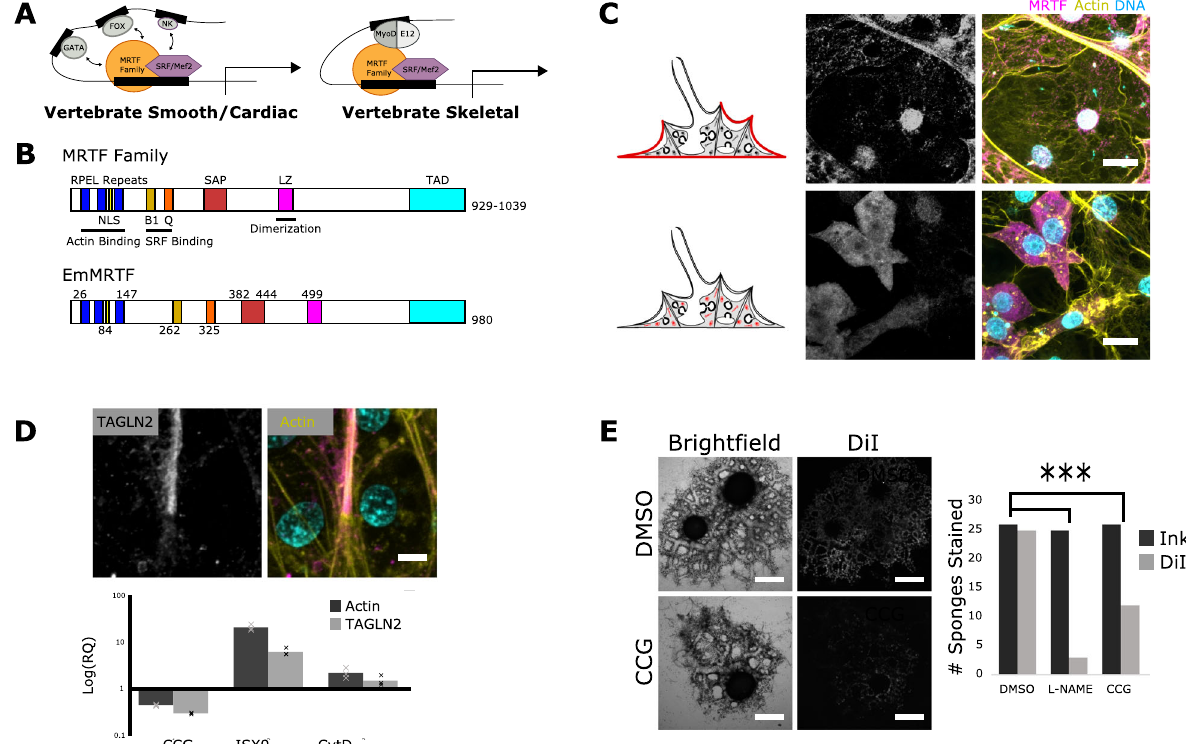
Fig. 5 Development of contractile structures depends on MRTF-activity. A Myocytes are developmentally speci fi ed by a transcriptional complex that includes MRTF interactions with SRF or Mef2. B Predicted domain organization of E. muelleri MRTF compared with vertebrate homologs (NLS; nuclear localization signal, B1, basic rich domain; SAP, SAP domain; LZ, leucine zipper; TAD, transcription activation domain). C Confocal images of pinacocytes (top) and archeocytes (bottom) immunostained for MRTF (grayscale and magenta), phalloidin (yellow), and Hoechst (cyan). Immunostainings for MRTF were performed on multiple sponges over fi ve independent experiments with consistent results. D Top: confocal images of an actin-bundle immunostained for TAGLN2 (grayscale and magenta), phalloidin (yellow) and Hoechst (cyan). Bottom: qPCR of TAGLN2 in response to treatment with CCG-203971 (20 μ M), ISX (50 μ M), and cytochalasin D (10 μ M) ( n = 3 technical replicates and 3 biological replicates). Data are presented as mean values (bars) with individual experimental values overlaid (crosses). Immunostainings for TAGLN2 were performed on multiple sponges over four independent experiments with consistent results. E Sponges pretreated with CCG-203971 were unable to clear ink-blockages by contraction ( χ 2(df2, N = 77) = 12.64, P - value = 0.002). A redrawn image from The evolutionary origin of bilaterian smooth and striated myocytes by Brunet T, et al., modi fi ed to generalize protein families and highlight central interaction, expressing relationships based on our phylogenetic analysis of MRTF family proteins, Creative Commons — Attribution 4.0 International — CC BY 4.0. Scale bars 500 μ m ( E ), 5 μ m in C , and 2 μ m in D . Contraction assays were performed three independent times with consistent To test the effects of MRTF-activation on contractile tissue downregulated genes as archeocyte-enriched. The ISX-treated differentiation, we dissociated juvenile sponges and treated samples had elevated expression of genes involved in contraction, archeocyte-enriched cell fractions with either DMSO or ISX signaling, development, and adhesion (Fig. 6D). Contraction- and placed them in an attachment-free environment (this allows related genes included stMyHC (LogFC = 0.65, P = 0.038), which for the formation of primary aggregates — primmorphs — but was validated by western blot (Fig. 6B), TAGLN2 (LogFC = 1.03, delays differentiation). After three days, control primmorphs P = 1.0E − 3 ), and components of the Ca 2 + -dependent MLCK pathway including MLCK-like serine/threonine kinase (LogFC = 1.58, P = 6.29E-5), calmodulin (LogFC = 1.55, P = 0.002), sodium/ calcium exchanger 1 (SLC8A1) (LogFC = 1.05, P = 0.029), and and treated primmorphs contained elevated levels of stMyHC Phospholipase C gamma (PLC γ ) (LogFC = 1.01, P = 0.005) (Fig. 6B). Thapsigargin had no effect on control primmorphs but (Fig. 6D). Upregulated signaling genes included metabotropic induced contractions in ISX-treated samples, which exhibited a glutamate receptors and GABA receptor subunits (Fig. 6D), con- sistent with a role for glutamatergic and GABAergic signaling in contractile behavior 2,3 . Upregulated developmental factors inclu- ded the myogenic transcription factor SRF (LogFC = 1.18, P = 0.001). Four Forkhead transcription factors showed increased expression, including Fox-L2 (LogFC = 1.07, P = 0.008), FoxG (LogFC = 1.31, P = 4.16E − 5 ), which is expressed in myocytes of invertebrates 45 , FoxO, and FoxJ1 (LogFC = 0.60, P = 0.016 and LogFC = 1.86, P = 0.001 respectively). The phylogenetically broad muscle marker Crip/Csrp 46 was also upregulated (LogFC = 1.10, P = 0.001).